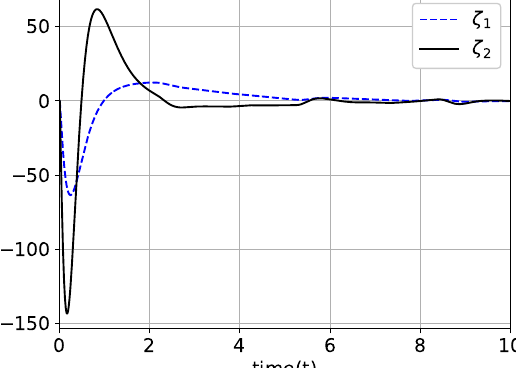
Figure 15. For HGO: ( a ) y , y d , and ( b ) u .